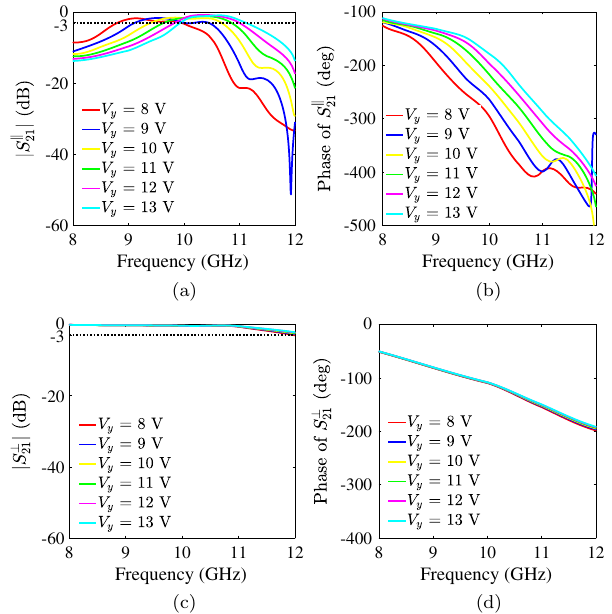
FIG. 13. Measured transmission response of the birefringent boards. (a) Transmission amplitude for the parallel polarization (y polarization for board 1 and x polarization for board 2 ). (b) Transmission phase for the parallel polarization. (c) Trans- mission amplitude for the perpendicular polarization (x polari- zation for board 1 and y polarization for board 2 ). (d) Transmission phase for the perpendicular polarization.